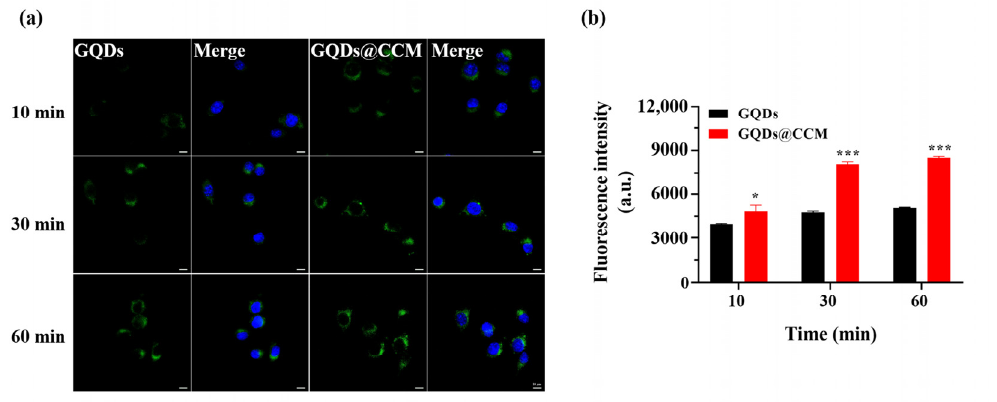
Figure 6. Cellular uptake of GQDs and GQDs@CCM. ( a ) CLSM images of BV2 cells incubated with GQDs or GQDs@CCM at a GQD concentration of 200 μ g/mL for different time periods. Scale bar = 10 μ m. ( b ) Quantitative analysis of BV2 cell uptake by FCM in different time periods. The differences among groups were determined by a one-way ANOVA analysis followed by the Tukey’s post-test: * p <0.05, *** p < 0.001.